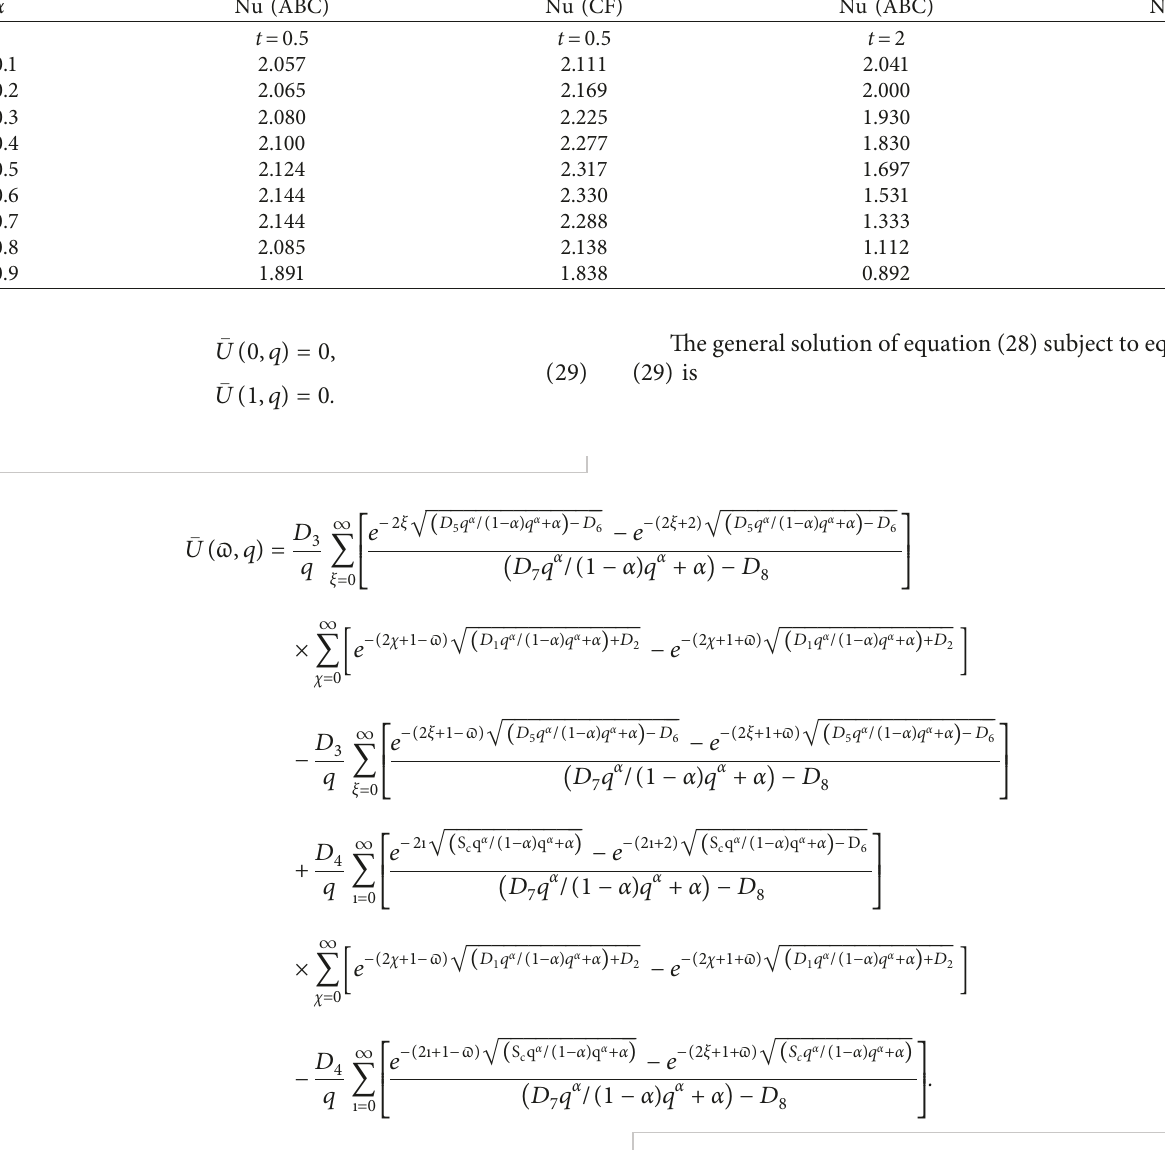
Table 4: Numerically analysis of Nusselt number for the effect of fractional parameter with comparison of (ABC) and (CF). α Nu (ABC) Nu